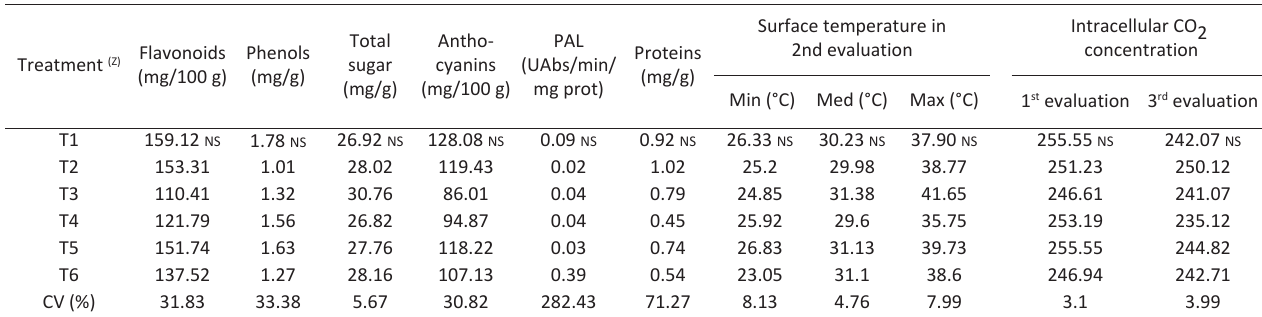
Table 2 - Flavonoids (mg/100 g), phenols (mg/g), total and reducing sugar (mg/g), anthocyanins (mg/100 g), PAL (UAbs/min/mg prot) and proteins (mg/g), minimum, average and maximum surface temperatures of the second evaluation, intracellular CO 2 concentration (μmol CO 2 mol -1 ) of the first and third evaluation, of Merlot vine submitted or not to management practices and the use or not of reflexive films on the soil, in productive cycle 1 (2009/2010)